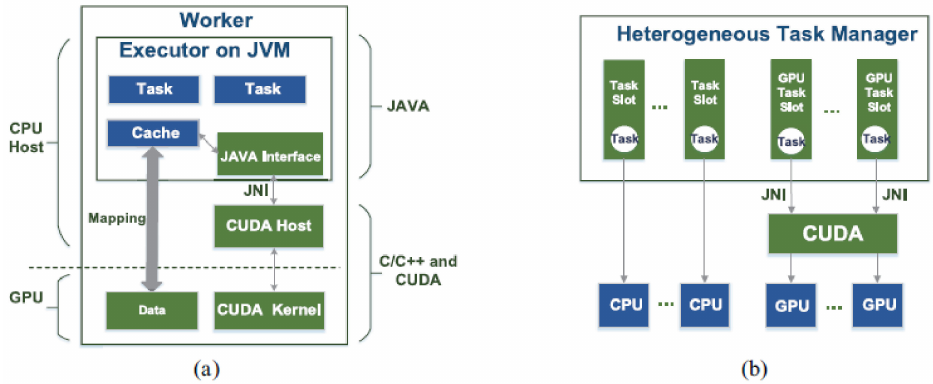
Figure 8. GFlink: ( a ) Architecture of a work node, ( b ) Heterogeneous task management [56]. (Reprinted with permission from ref. [56]. Copyright 2021